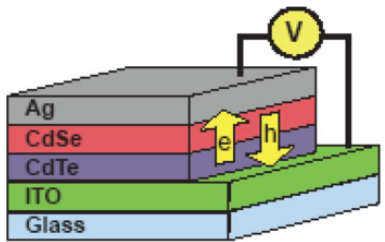
Figure 20. Schematic view of a PV cell composed of indium ‐ tin oxide (ITO) coated glass, CdTe and CdSe nanorods, and silver paint. Electrons (holes) are preferentially pushed towards the Ag (ITO)